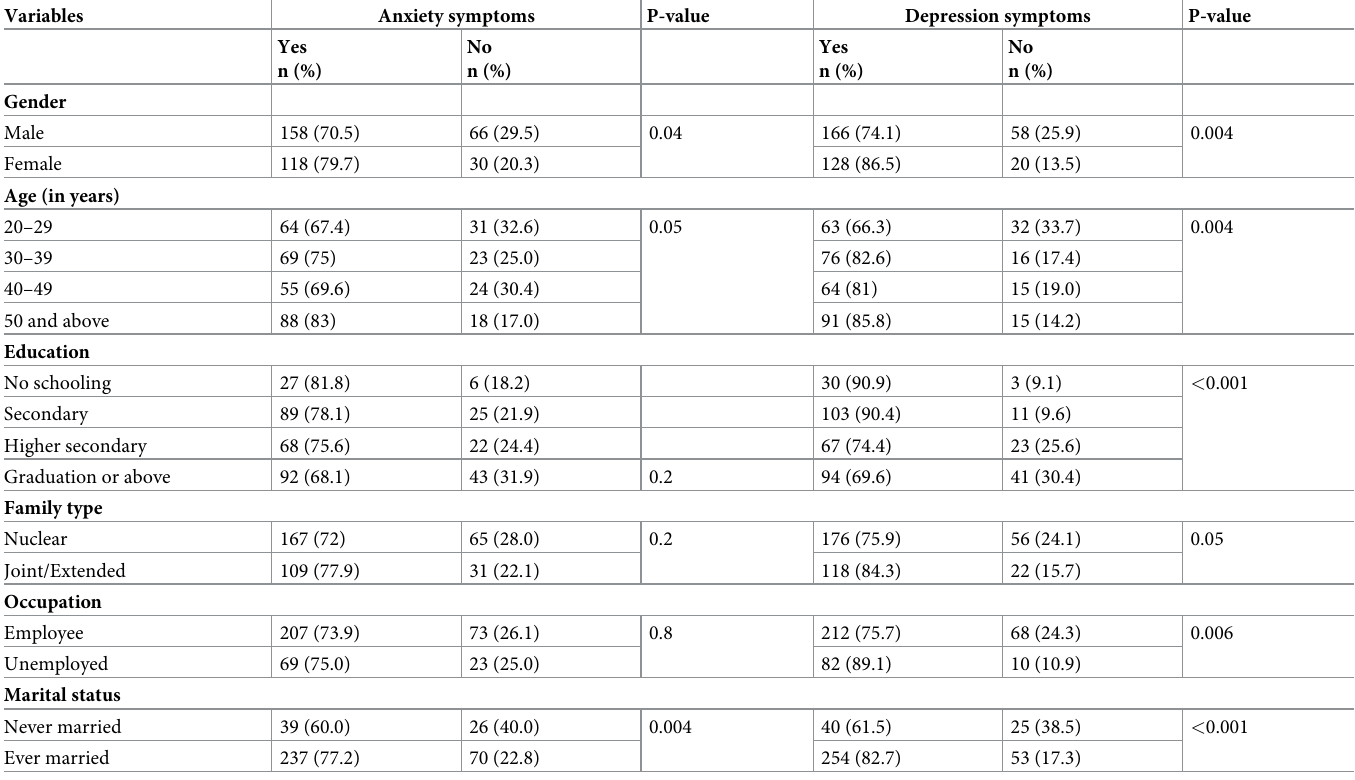
Table 2. Sociodemographic characteristics of the